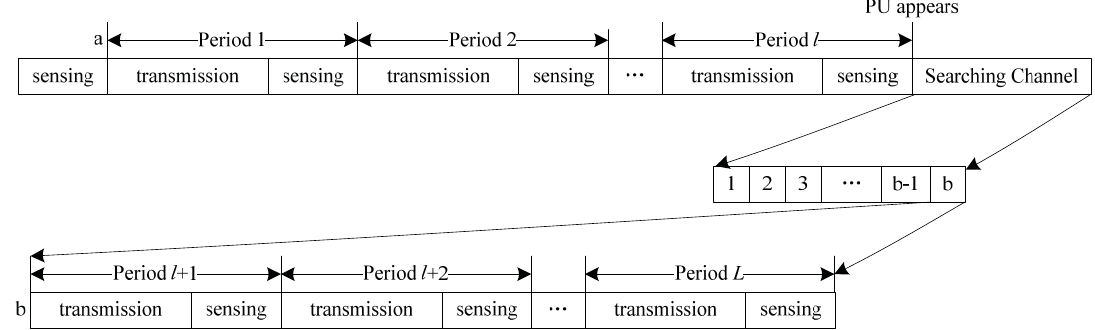
Figure 6. Processes of sensing spectrum and searching